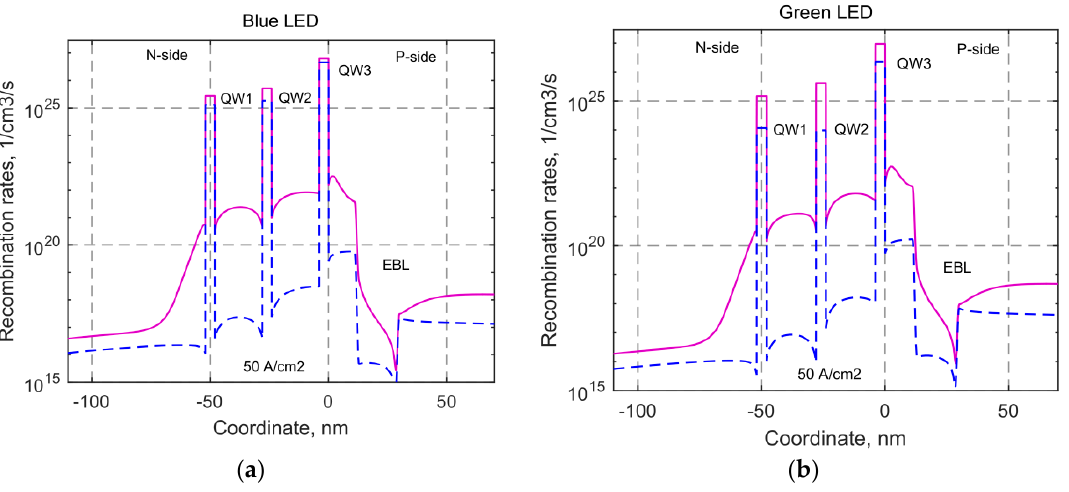
Figure 2. Recombination rate profiles across the active region of ( a ) blue-emitting and ( b ) green-emitting LEDs at a nominal injection current of 50 A/cm 2 . Dashed lines indicate the radiative recombination rates.